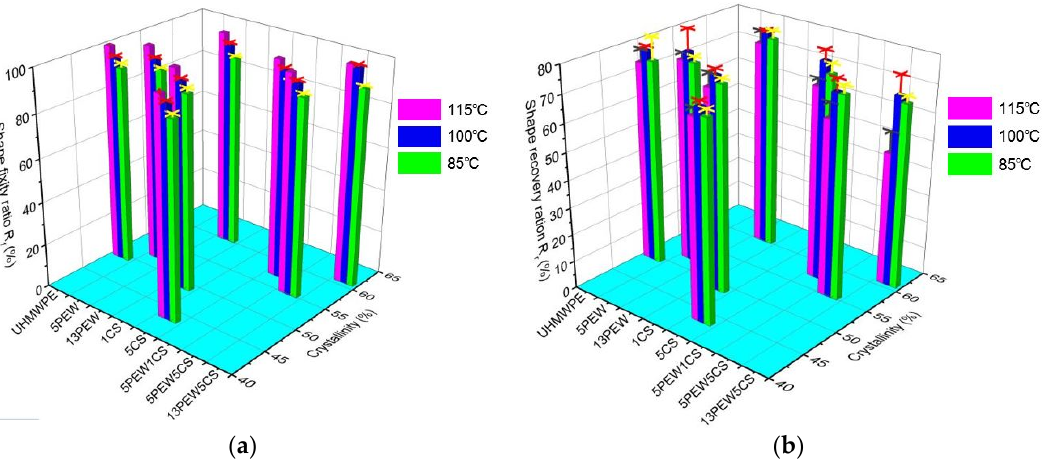
Figure 10. Shape memory properties of the samples: ( a ) shape fixity ratio; ( b ) shape recovery ratio.